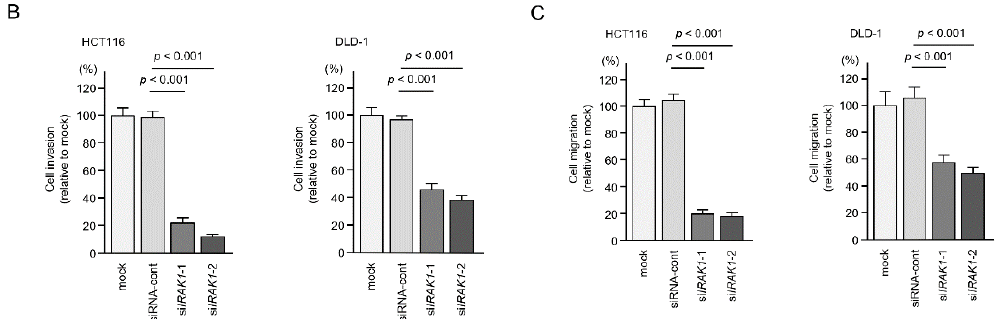
Figure 9. Effects of knockdown of IRAK1 in colorectal cancer (CRC) cells (HCT116 and DLD-1). Functional assays of IRAK1 (si IRAK1 -1 and si IRAK1 -2 transfection) in CRC cells. ( A ) Cell proliferation assessed by XTT assay 72 h after transfection of siRNA ( B ) Cell invasion determined by Matrigel invasion assay 48 h after seeding inhibitor-transfected cells into the chambers. ( C ) Cell migration assessed using a membrane culture system 48 h after seeding inhibitor-transfected cells into the chambers.